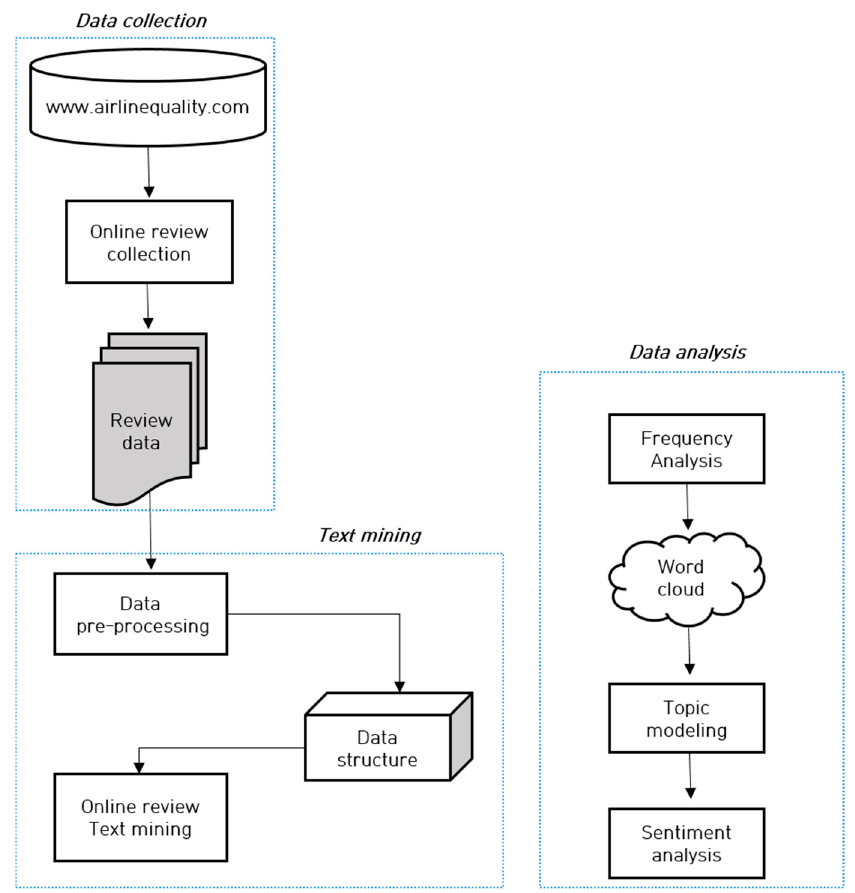
Figure 1. Research procedure.